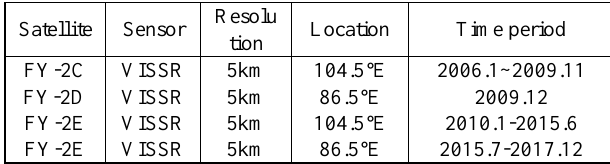
Table 1. The information of CTA products of FY satellites Figure 1 shows a cloud information sample of FY CTA products. The CTA is the area percentage of cloud in a pixel. It ranges from 0 to 1.0, indicating clear and totally cloud covered area, respectively. The product is hierarchical data format (HDF) with the geostationary projection (NSMC,